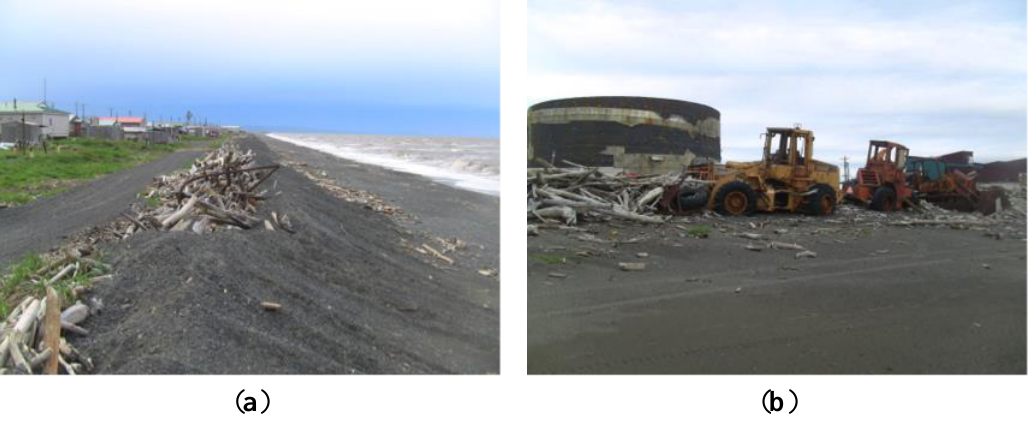
Figure 4. ( a ) Berm construction efforts in Shaktoolik include piling up driftwood, and ( b ) other material including scrap front-end loaders, in an effort to construct the